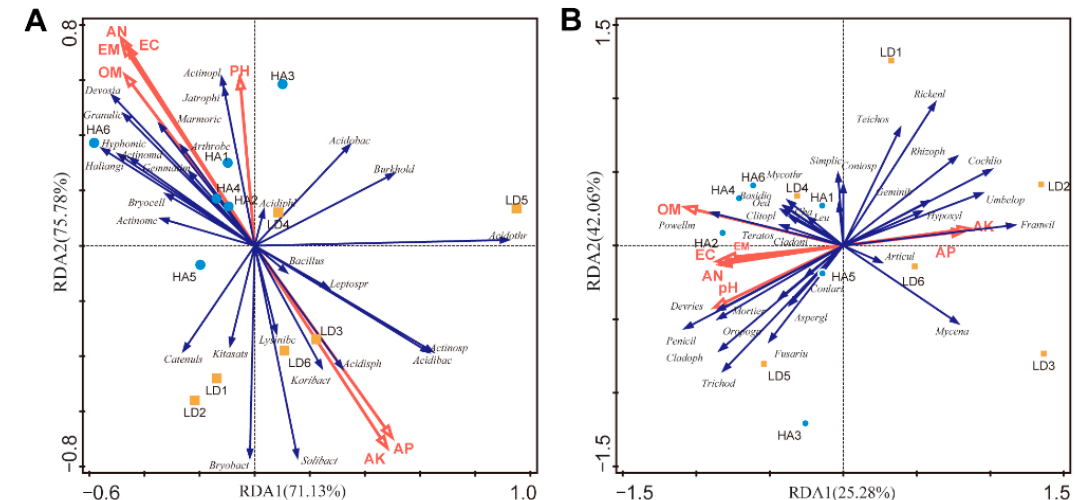
Figure 4. RDA of the rhizosphere microbial community composition at a genus level with soil phys- iological and chemical properties. RDA: Redundancy discriminant analysis; PH: pH; OM: organic